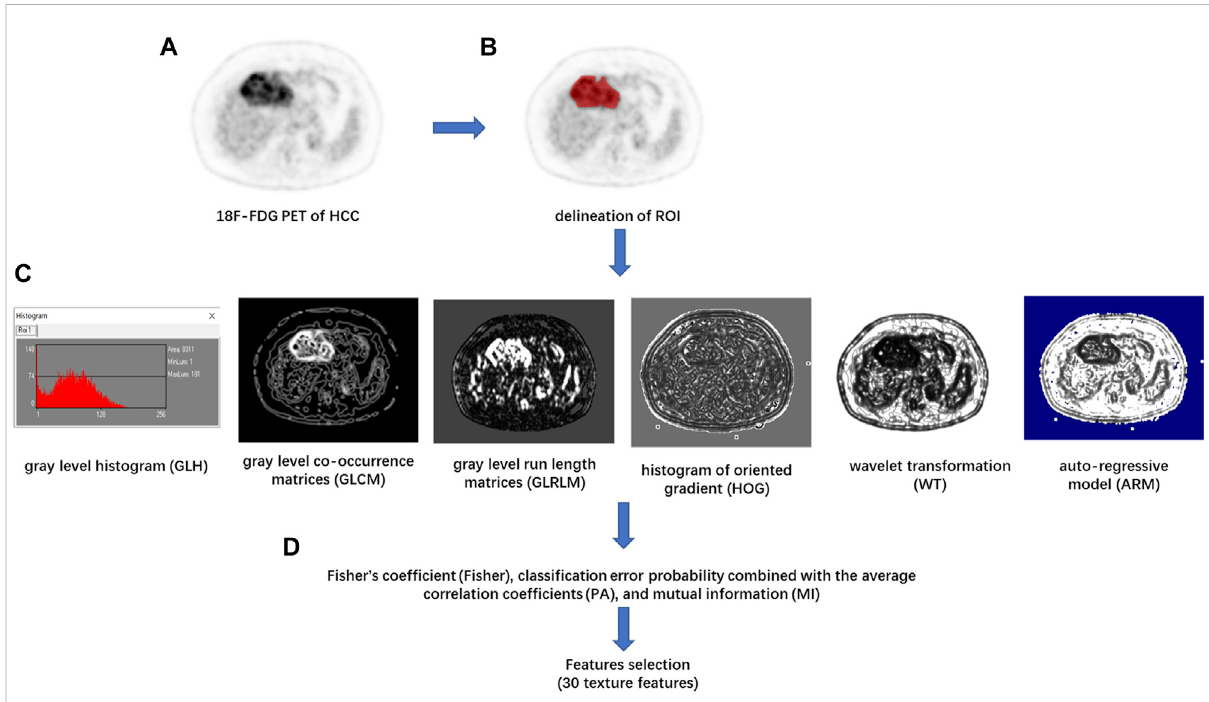
FIGURE 1 Flowchart of texture features (TF) extraction. (A) The 18 F-FDG PET image of the maximum axial section of hepatocellular carcinoma (HCC) was chosen. (B) The region of interest (ROI) of the tumor was drawn in red on MaZda. (C) The gray level histogram (GLH), gray level co-occurrence matrices(GLCM),graylevelrunlengthmatrices(GLRLM),histogramoforientedgradient(HOG),wavelettransformation(WT),andtheautoregressive model (ARM) of tumor were calculated, respectively. (D) A combination of feature selection algorithms, including Fisher ’ s coef fi cient (Fisher), classi fi cation error probability combined with the average correlation coef fi cients (PA), and mutual information (MI), was used to determine 30 texture features with the highest discriminative power for differentiation HCC with or without between